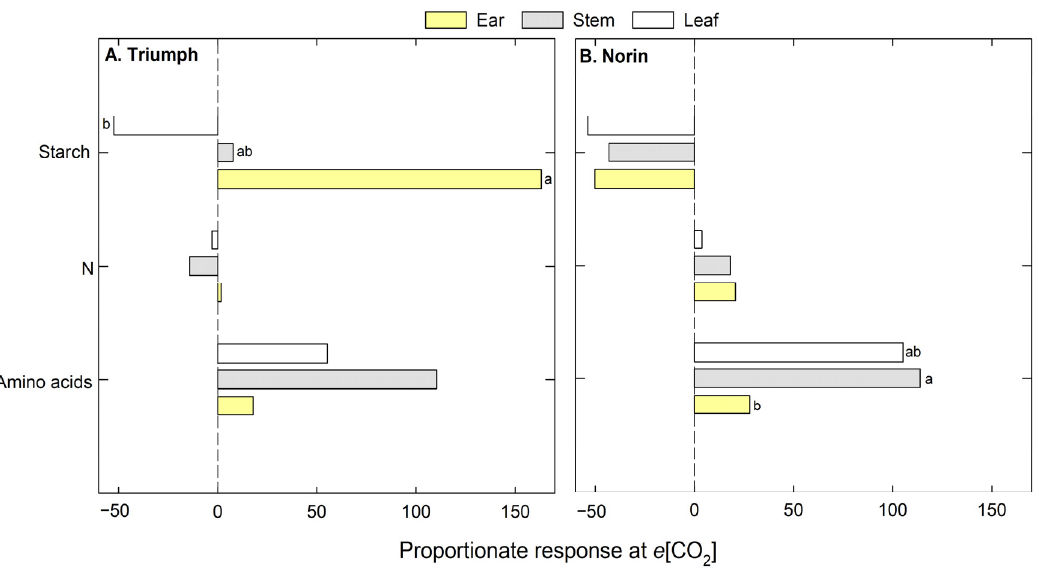
Figure 4. Percentage (%) of change under e [CO 2 ] relative to a [CO 2 ] in three organs evaluated (stems, leaves, and ears) at anthesis in both wheat cultivars: ( A ) Triumph and ( B ) Norin. The letters indicate significant differences between organs ( p <